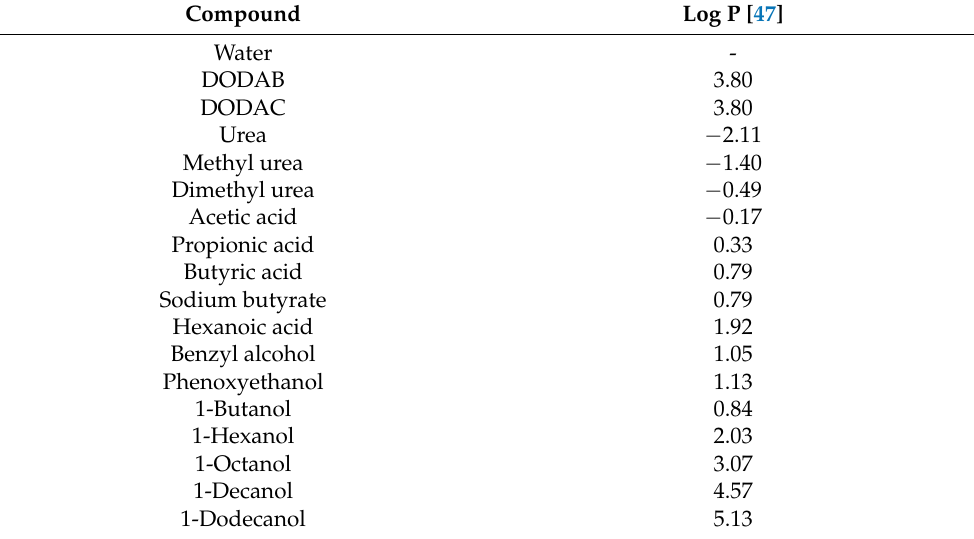
Table 6. Logarithm of the octanol/water partition coefficient for additives